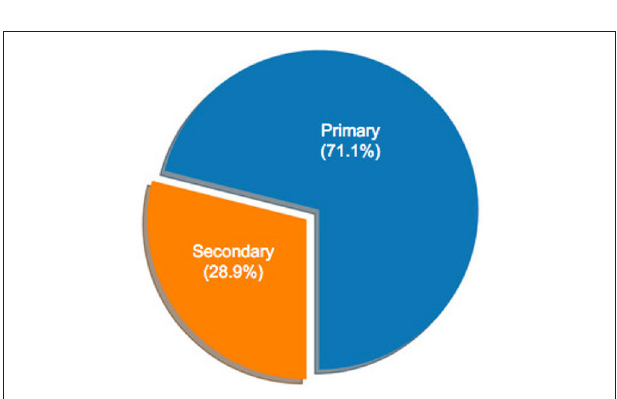
FIGURE 1 | Distribution of sample articles by type.